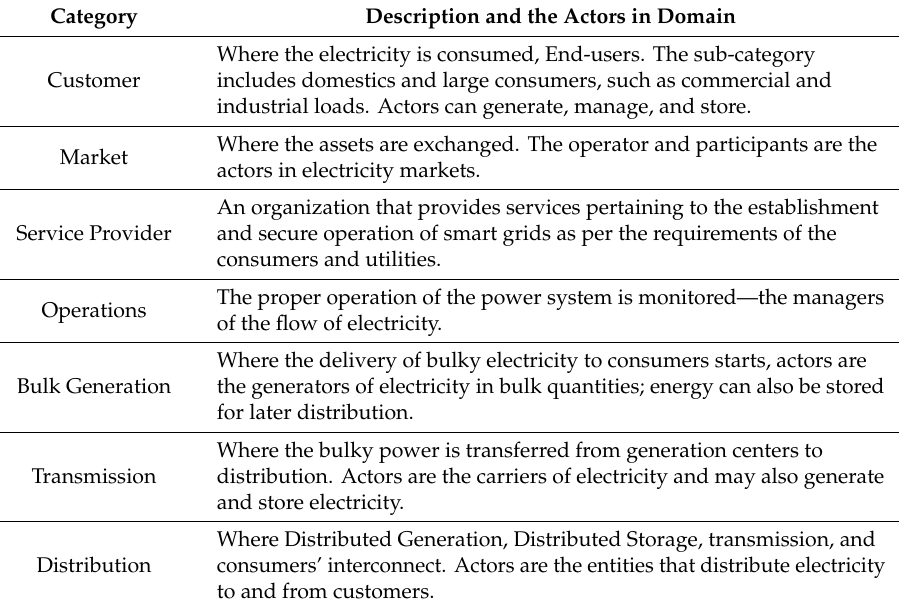
Table 2. Classification and elements of smart grids